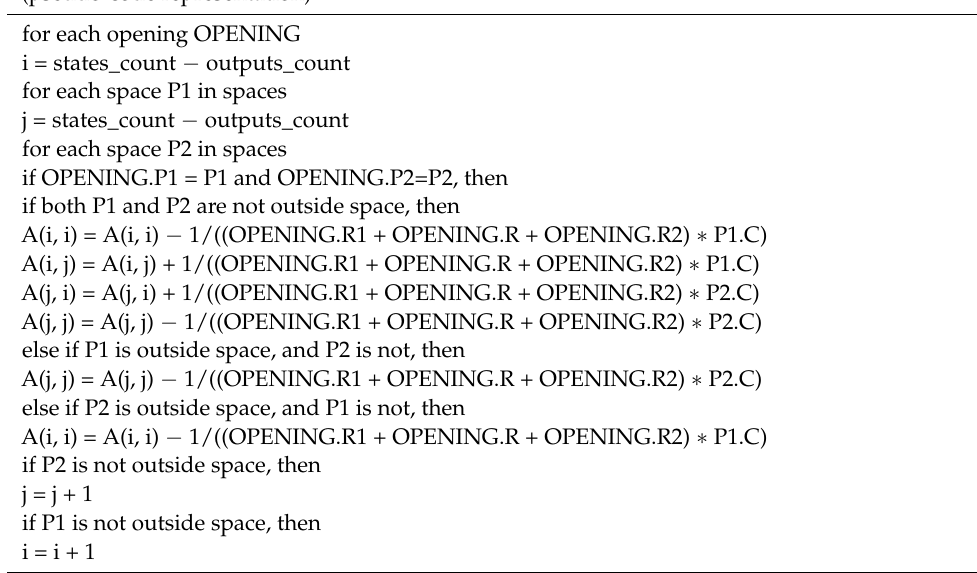
Algorithm 3. The modification of the state matrix A —openings and spaces